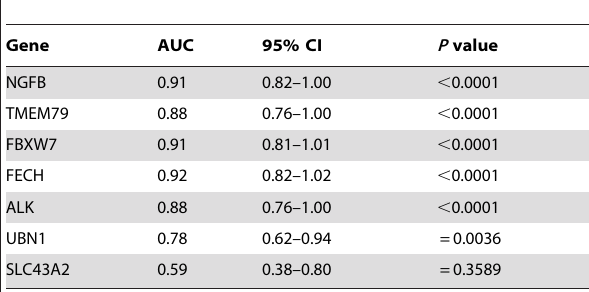
Table 5. ROC curve statistical